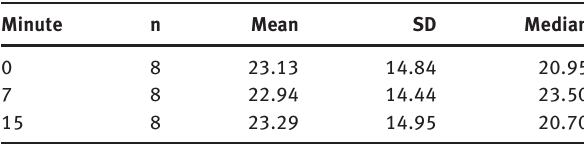
Table 2: Breast milk concentration of neopterin, nmol/L, at various phases of a single